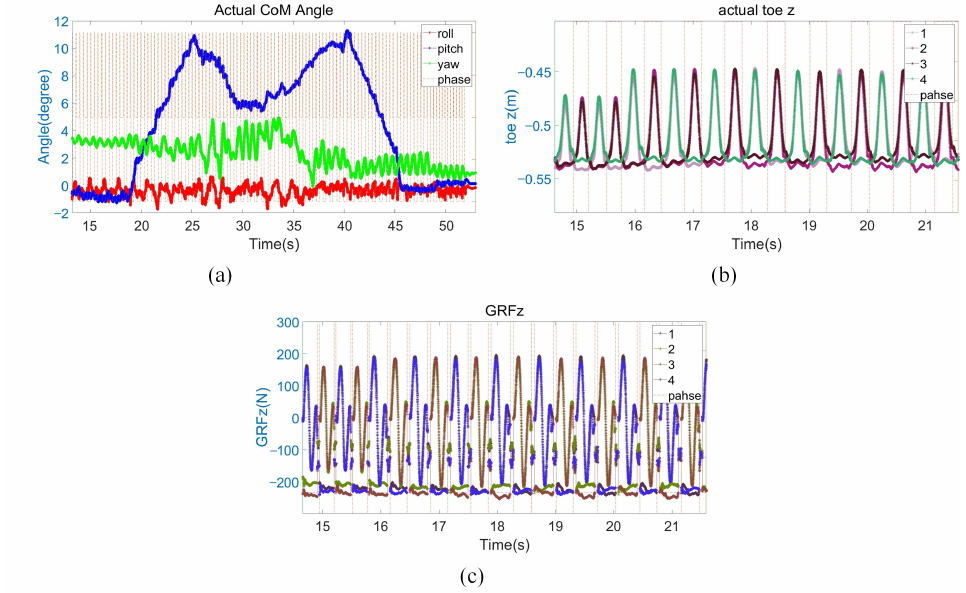
Figure 14. The 12° slope experiment data. ( a ) Robot body angle. The red, blue, and green lines present the robot body roll, pitch, and yaw angles; ( b ) the z-direction position of the foot end of the four legs; ( c ) GRF in the